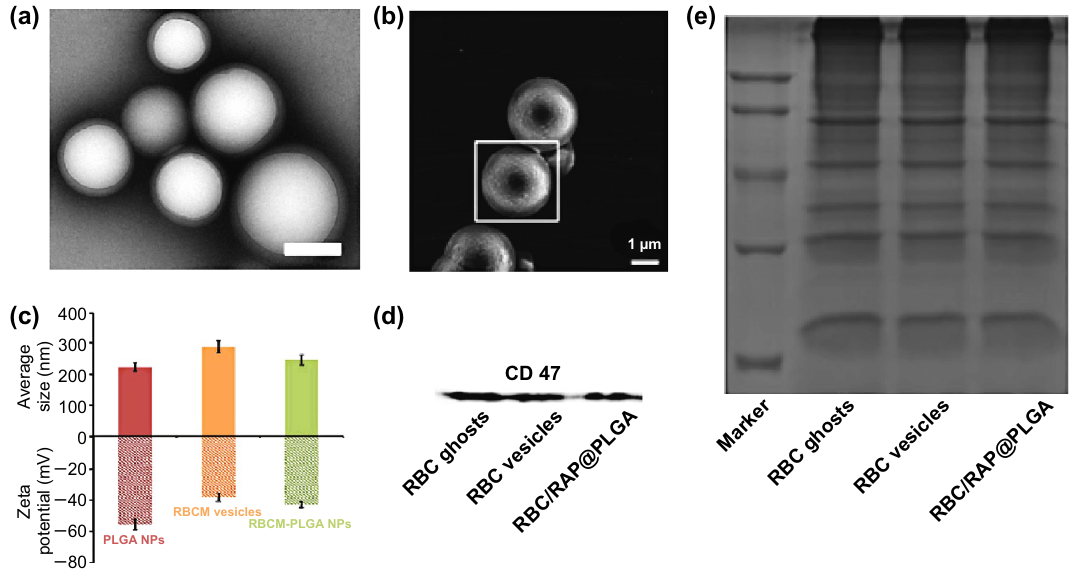
Fig. 2 Cell membrane‑coated NP characterization. a TEM image of RBCM‑NPs showing the core–shell structure. Scale bar, 200 nm. Adapted from Ref. [36] with permission. b SEM images of the platelet membrane‑derived vehicle‑coated Si particles. Adapted from Ref. [82] with permission. c Average sizes and zeta potentials of PLGA NPs, RBC membrane vesicles, and RBCM‑PLGA NPs. Adapted from Ref. [36] with permission. d CD47 levels measured by Western blotting demonstrating the retention of characteristic membrane proteins. e SDS‑PAGE protein analysis of RBC‑ghost, RBC‑vesicle, and RBCM‑NPs. Adapted from Ref. [83] with